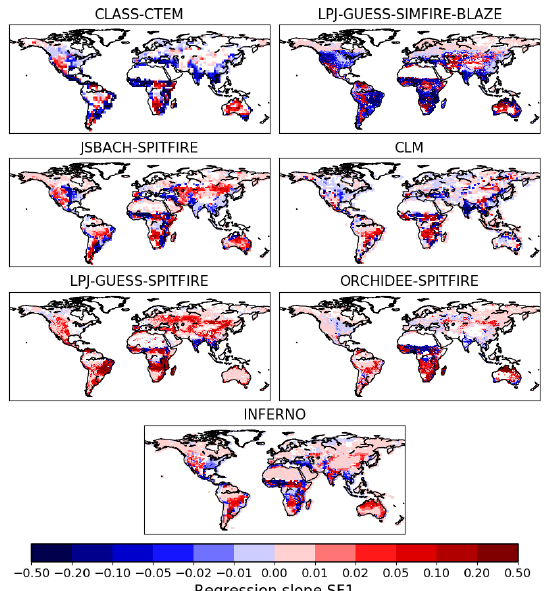
Figure A2. Spatial distribution of regression slopes for the baseline experiment SF1 over